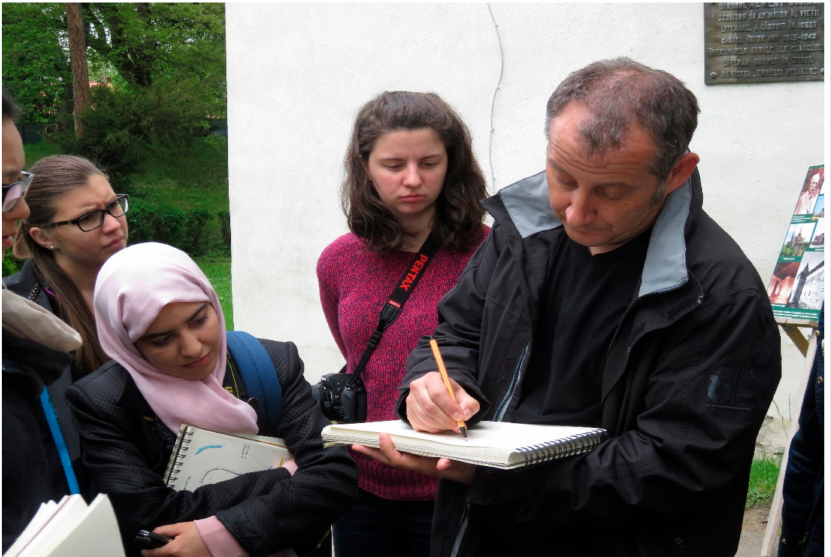
Figure 9. The role of the teacher in fieldwork is not only leading students from one point to another. Teaching fieldwork demands from the teacher an active attitude in the interaction with students. Here a moment where Albert Fekete finds out that students did not really understand the structure of a park and where he immediately interferes with drawing the structure in a notebook of one of the students. Drawing is in this case a way of explaining a structural principle by a